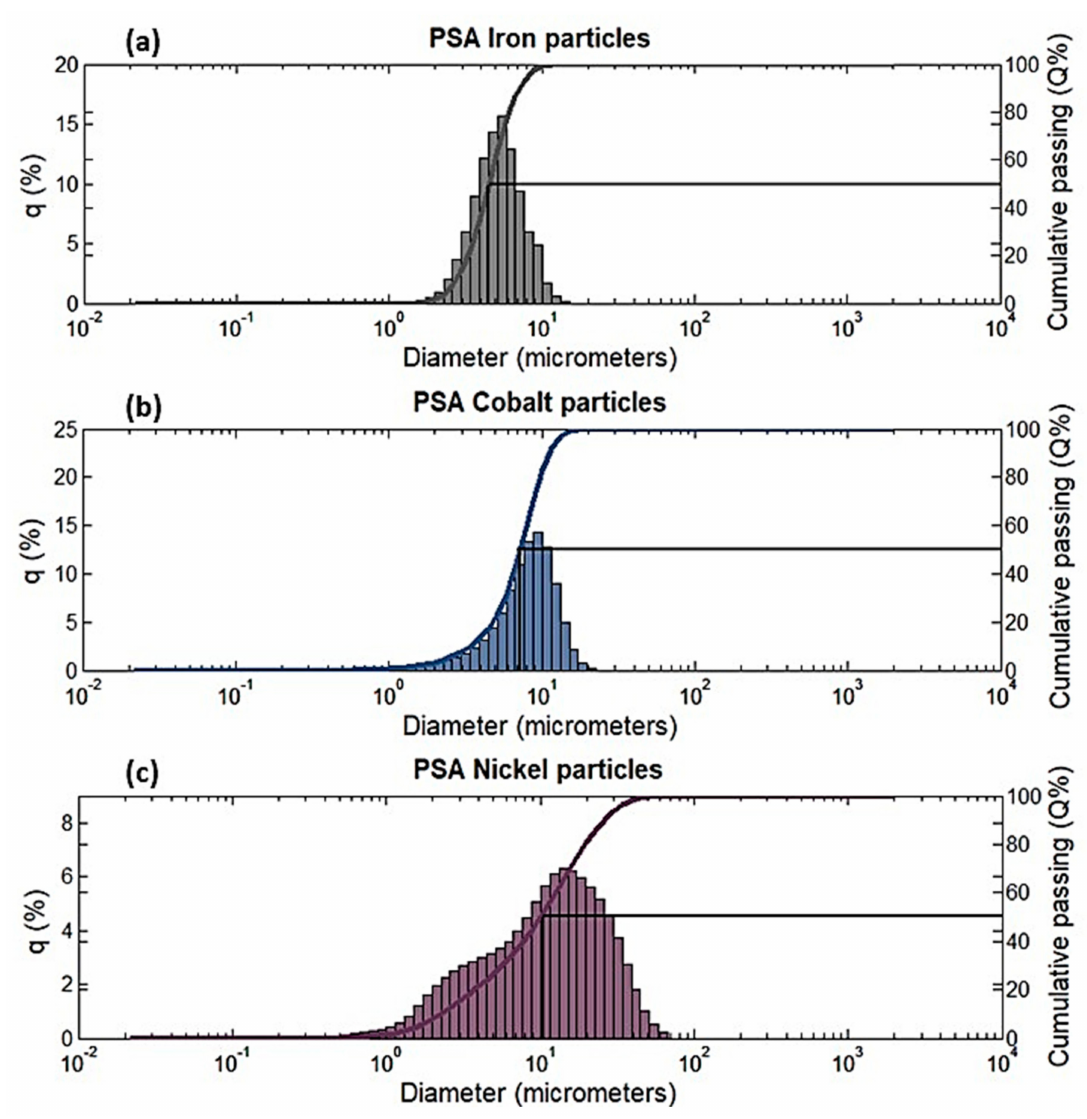
Figure 1. Particle size analysis graphs of ( a ) Iron filler particles ( b ) Cobalt filler particles ( c ) Nickel filler